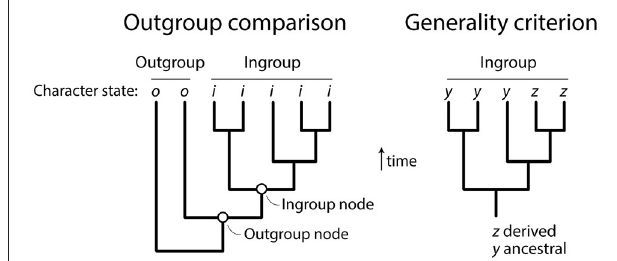
FIGURE 1 | Comparing the indirect outgroup comparison method of rooting trees and the direct generality criterion. Rooting involves orienting an unrooted tree and pulling down a branch that will hold the ancestor of all taxa examined. In outgroup comparison, sister (outgroup) taxa external to the study group (ingroup taxa) are identified a priori of being of ancestral origin and the branch that is closest to the ingroup pulled down. This creates a new outgroup node for rooting the phylogeny. The outgroup node adds a character state vector that includes character state o , which is diagnostic of the outgroup and is assumed to be ancestral and absent in the ingroup. Once the outgroup is made ancestral, the tree is rooted and character state i is shared and derived, making it a synapomorphy. In Weston’s generality criterion (Weston, 1988, 1994 ), the character state distributions in the phylogeny are used to polarize character transformations. Character state z is less distributed than y within the ingroup (it is present only in a minority subset of taxa) and is considered shared and derived. The figure was modified from Bryant